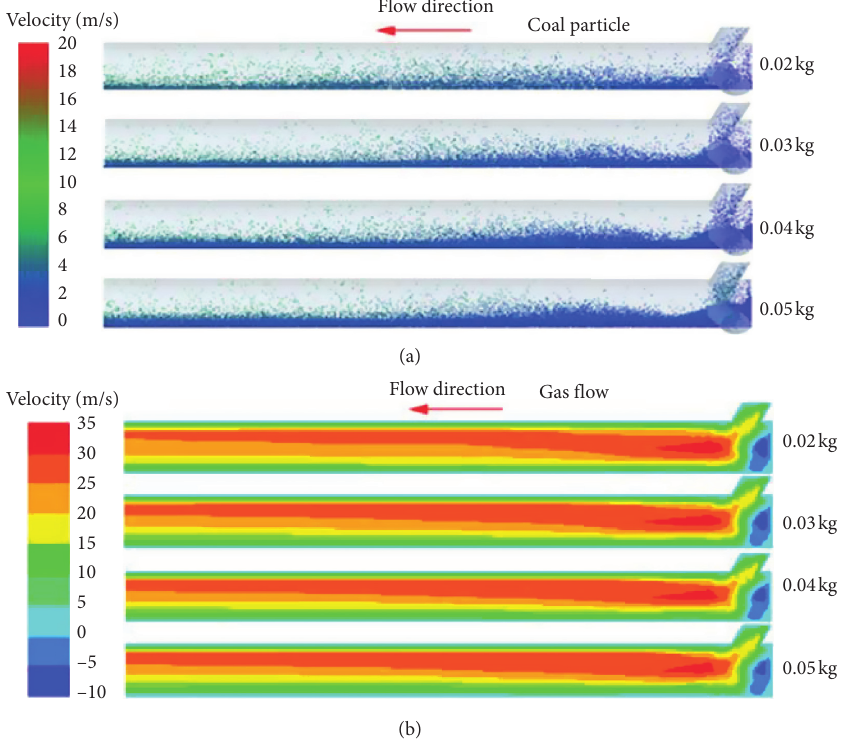
Figure 6: The coal-gas flow characteristic in drilling bit-rod integral structure 0 ∼ 0.5m under gas velocity 25m/s ( t � 3 s).